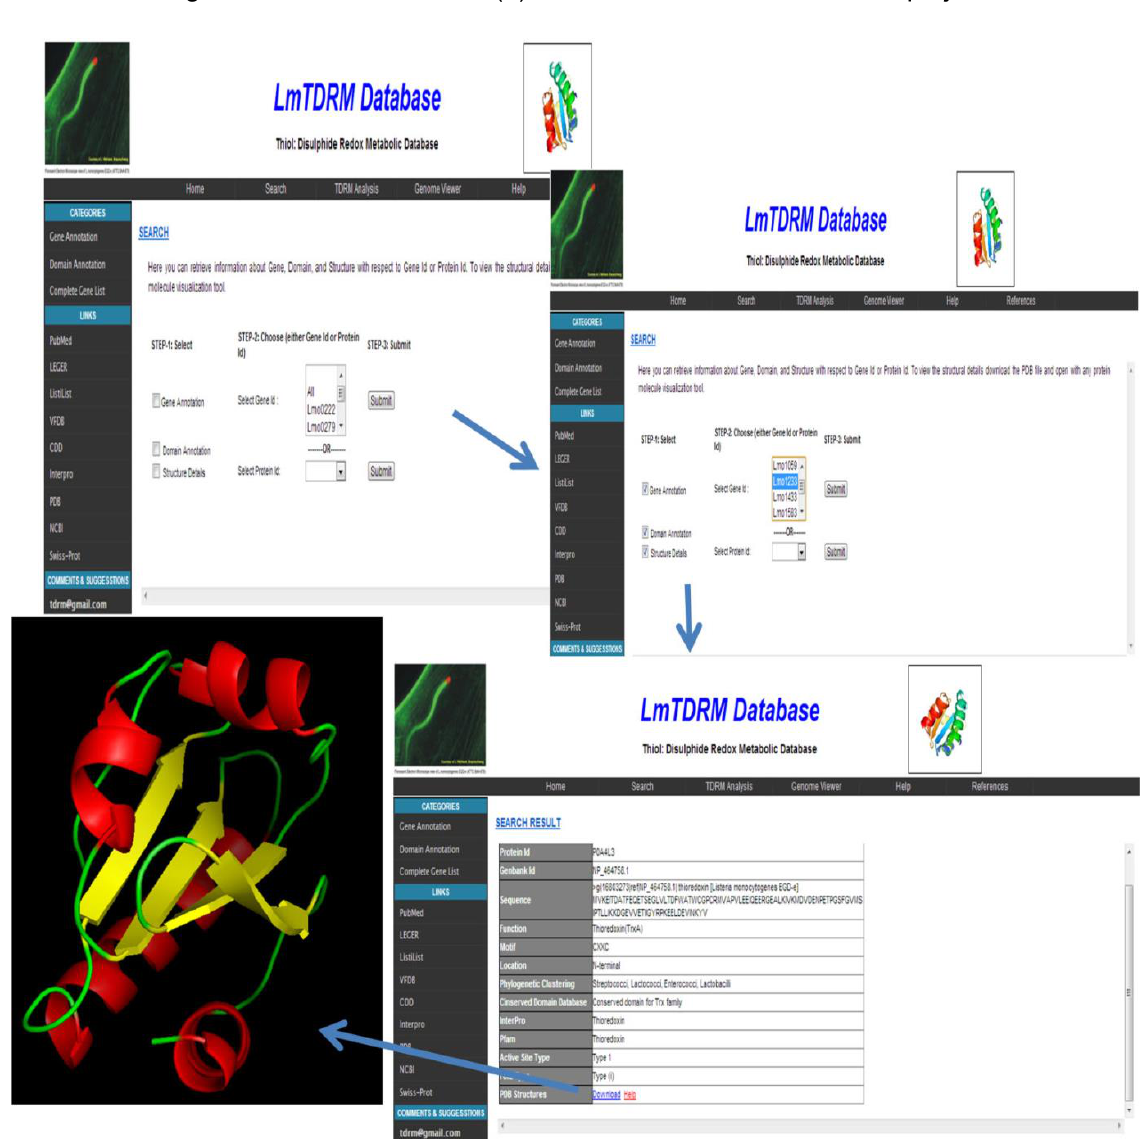
Figure 5: LmTDRM database: Screenshot of search page with details and structure. Query results represent the complete information of the gene and structure details. PDB files can be downloaded and viewed using